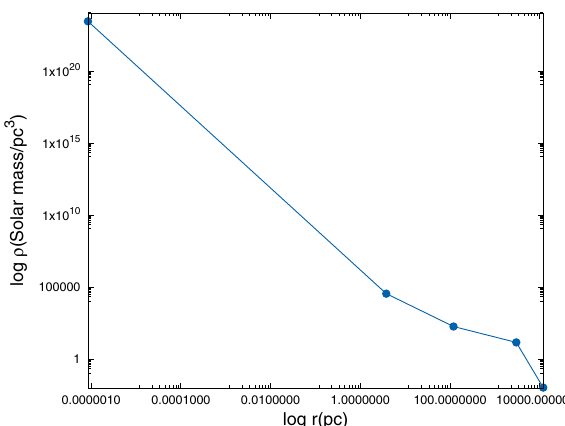
Fig. 1 Variationoflogofaccretiondensity(in M (cid:4) distance (in Pc unit) curve drawn from the data generated by the model considered in the reference [5]. We notice extremely high density near the core. As we go to outer regions, density falls